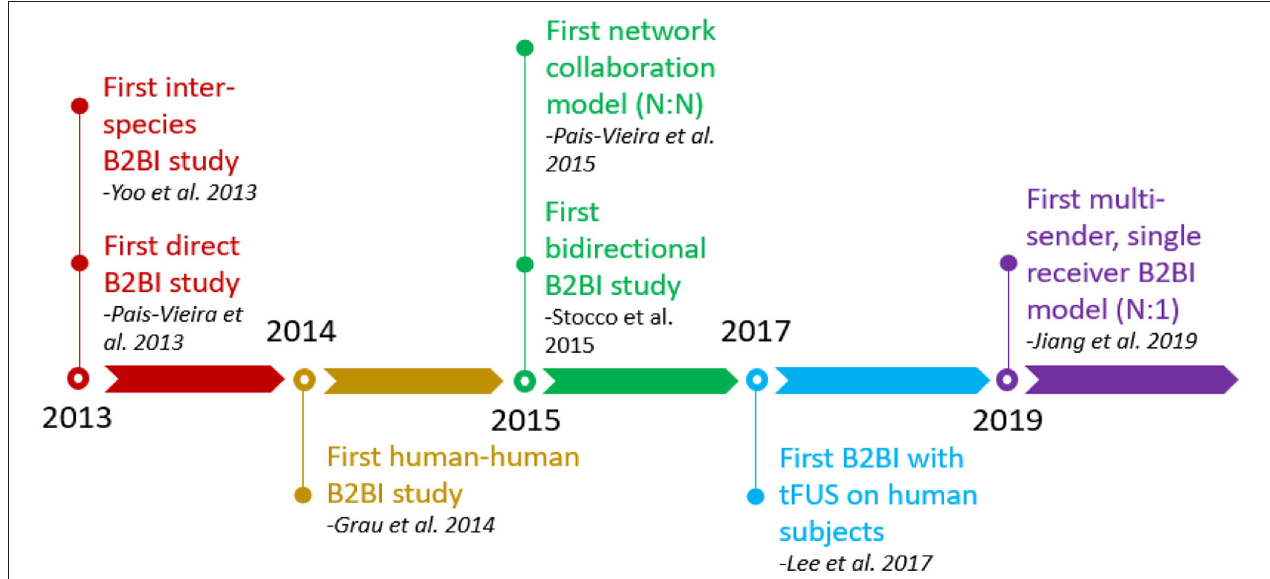
FIGURE 1 | Timelines of advancement in brain-to-brain interface (B2BI)